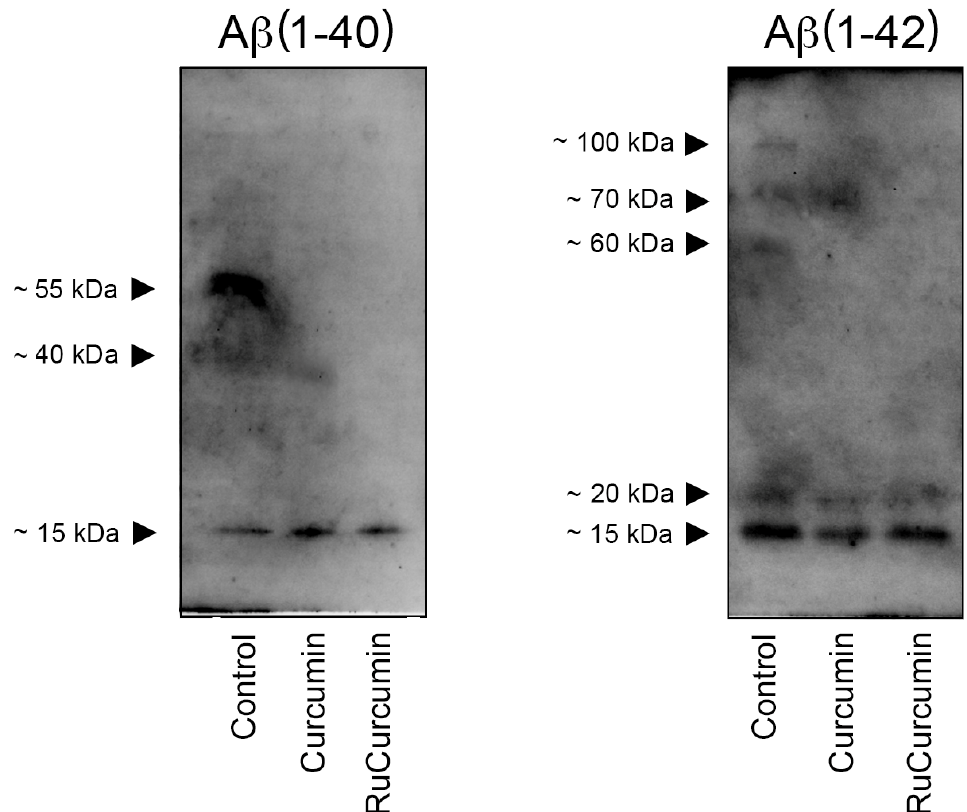
Figure 4. Western blot of A β (1–40) and A β (1–42) oligomers grown for 24 h, under the conditions described in the Materials and Methods section, in the presence and in the absence of 20 μ M curcumin or